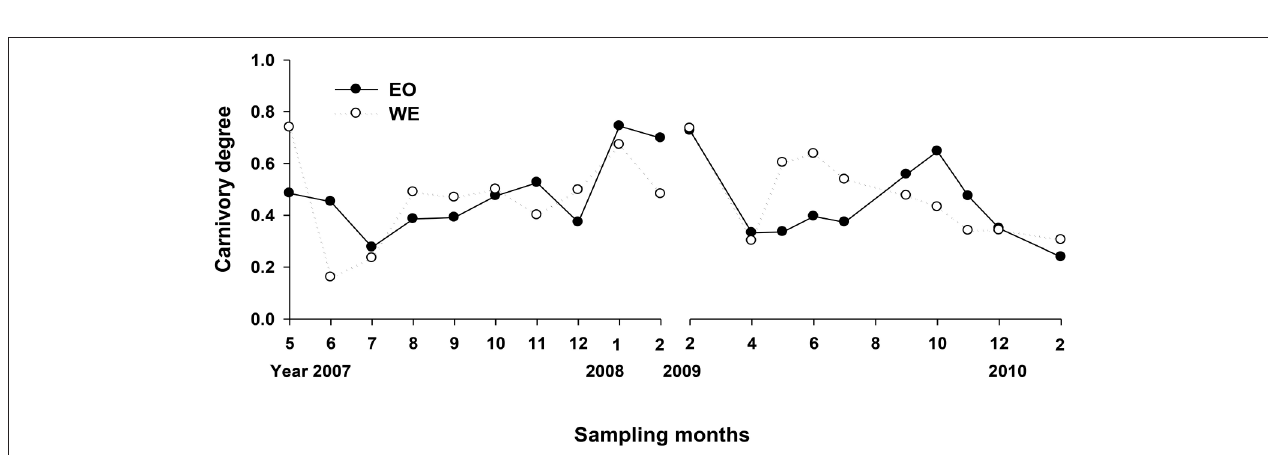
FIGURE 3 | Composition of Chl a in different size-fractionated phytoplankton. Large-sized: phytoplankton > 20 µ m; Middle-sized: phytoplankton 2 ∼ 20 µ m in the first sampling year and phytoplankton 5 ∼ 20 µ m in the second sampling year; Small-sized: phytoplankton < 2 µ m in the first sampling year and phytoplankton < 5 µ m in the second sampling year.